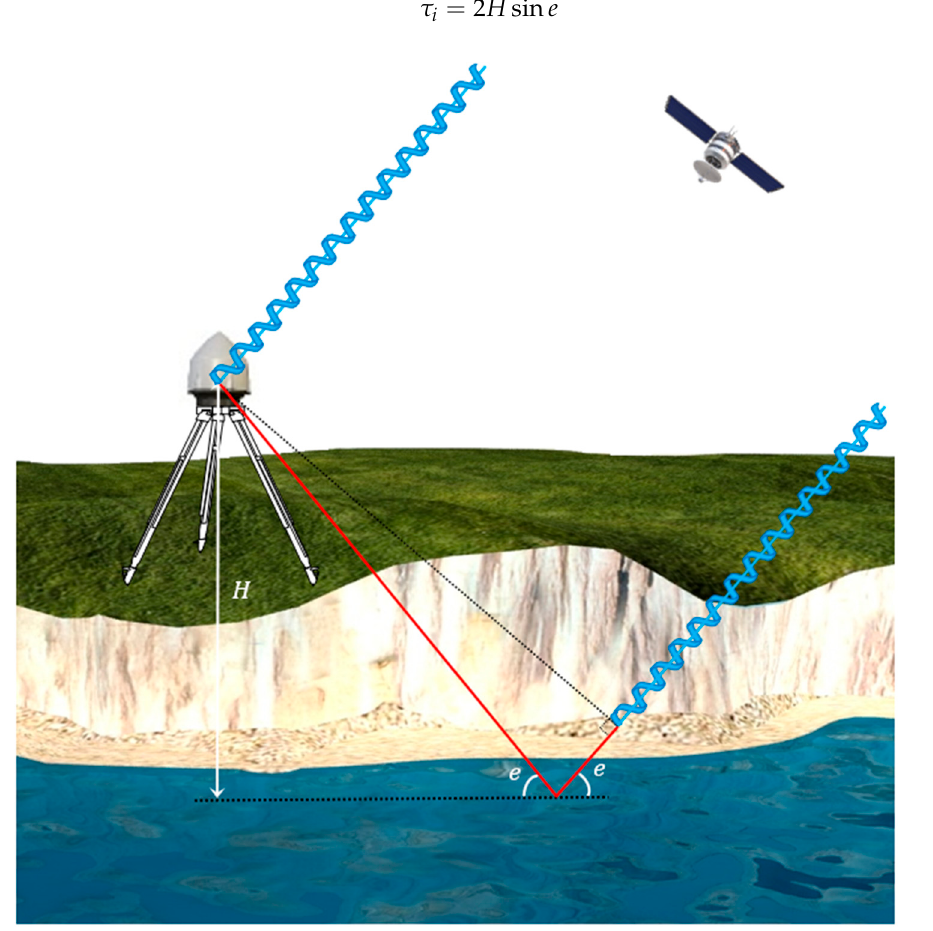
Figure 3. Geometry of a geodetic GNSS-R in vacuum. The red lines show excess path delay traveled by the sea-surface reflection relative to the direct signal (blue).